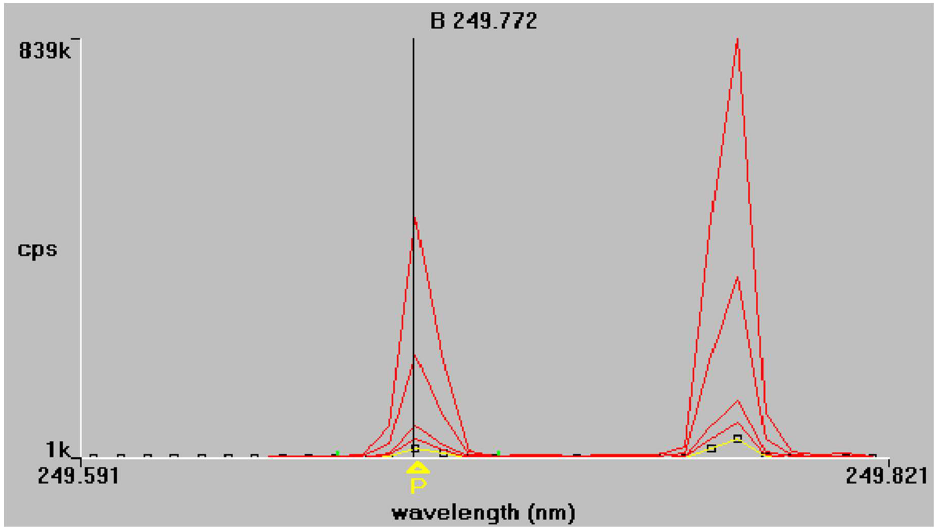
Figure 2. Boron emission spectra at 249.772 nm and 249.677 nm respectively. Superimposed traces refer to standard solutions of increasing concentration, as described in the text.